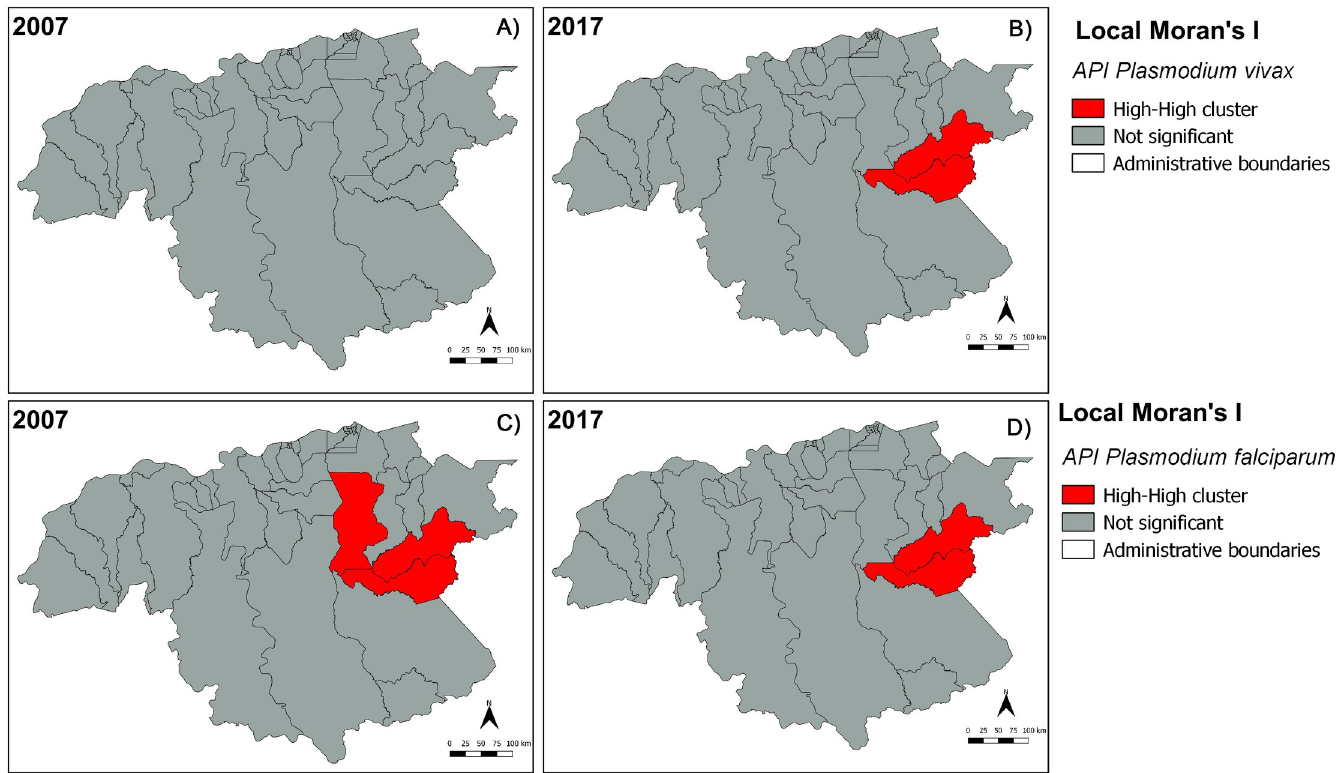
Fig 4. Significant clusters (hotspots) of annual Plasmodium vivax (A, B) and P . falciparum (C, D) incidence (red-red) in Bolı´var state (south-eastern Venezuela), during 2007 and 2017. Maps were created with the Q-GIS software (https://www.qgis.org/es/site/).